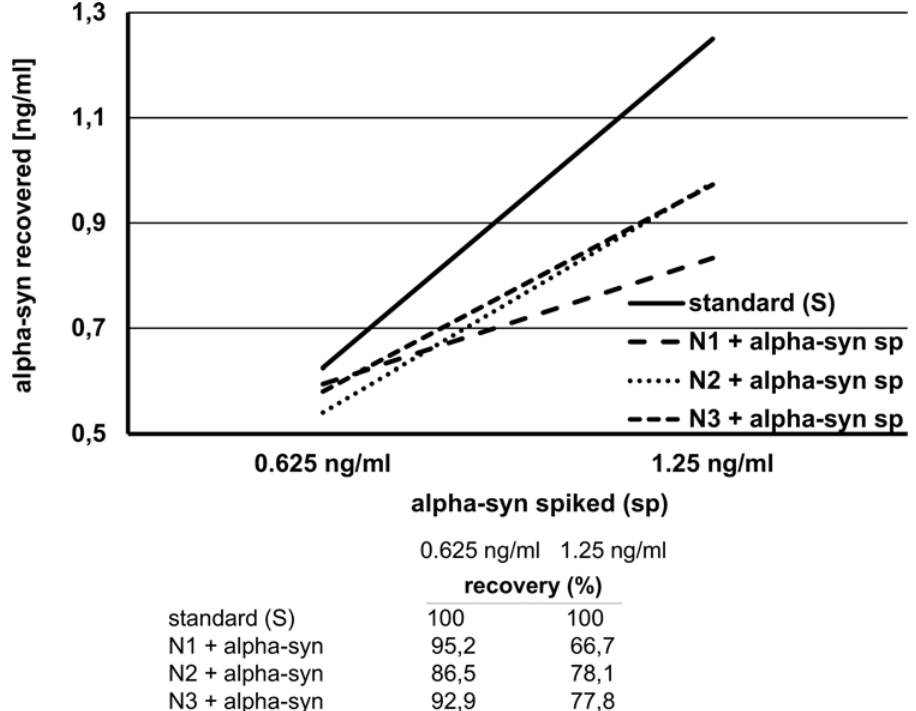
Fig 4. Spike and recovery. Three native plasmas N1, N2 and N3 were spiked (sp) with alpha-synuclein (alpha-syn) at 0.625 ng/ml and 1.25 ng/ml, equivalent to the amount that was added to standard solutions (S). Recovery (%) of spiked alpha-synuclein was calculated by subtraction of the internal alpha-synuclein in the native plasma (given in